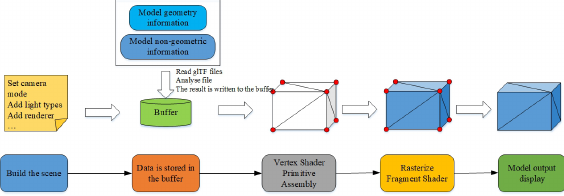
Fig. 6. The visualization process of glTF file based on WebGL